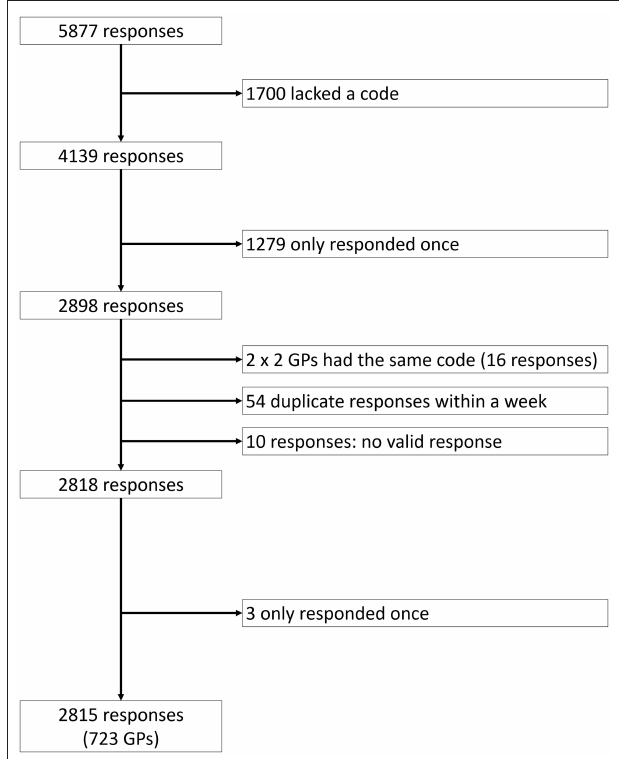
FIGURE 4 | Interaction of GPs with their GP colleagues during the study